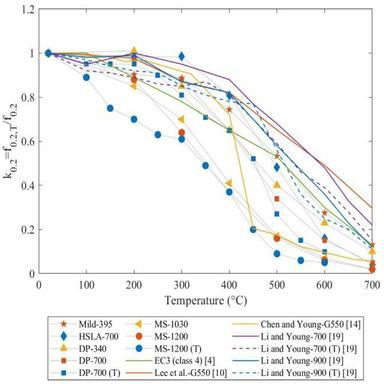
Comparison of 0.2% proof stress (transient-state test results are marked with 'T').